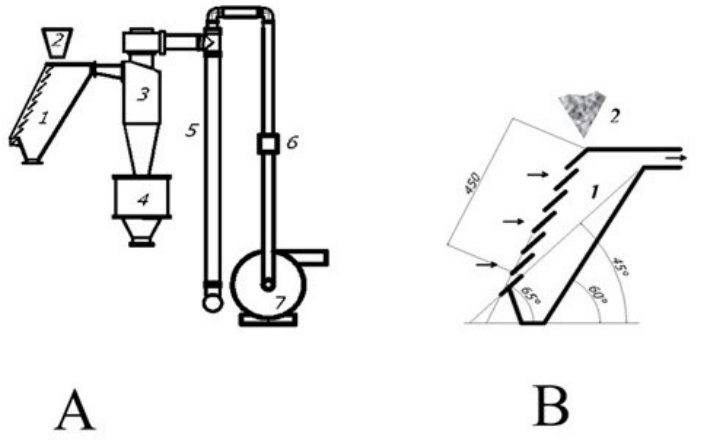
Figure 1. Layout of the laboratory tailings screening equipment ( A ) pitched curtain air classifier design ( B ): 1—air classifier; 2—material feeder; 3—air cyclone; 4—fine particle collector; 5—hose filter; 6—flowmeter; 7—high pressure